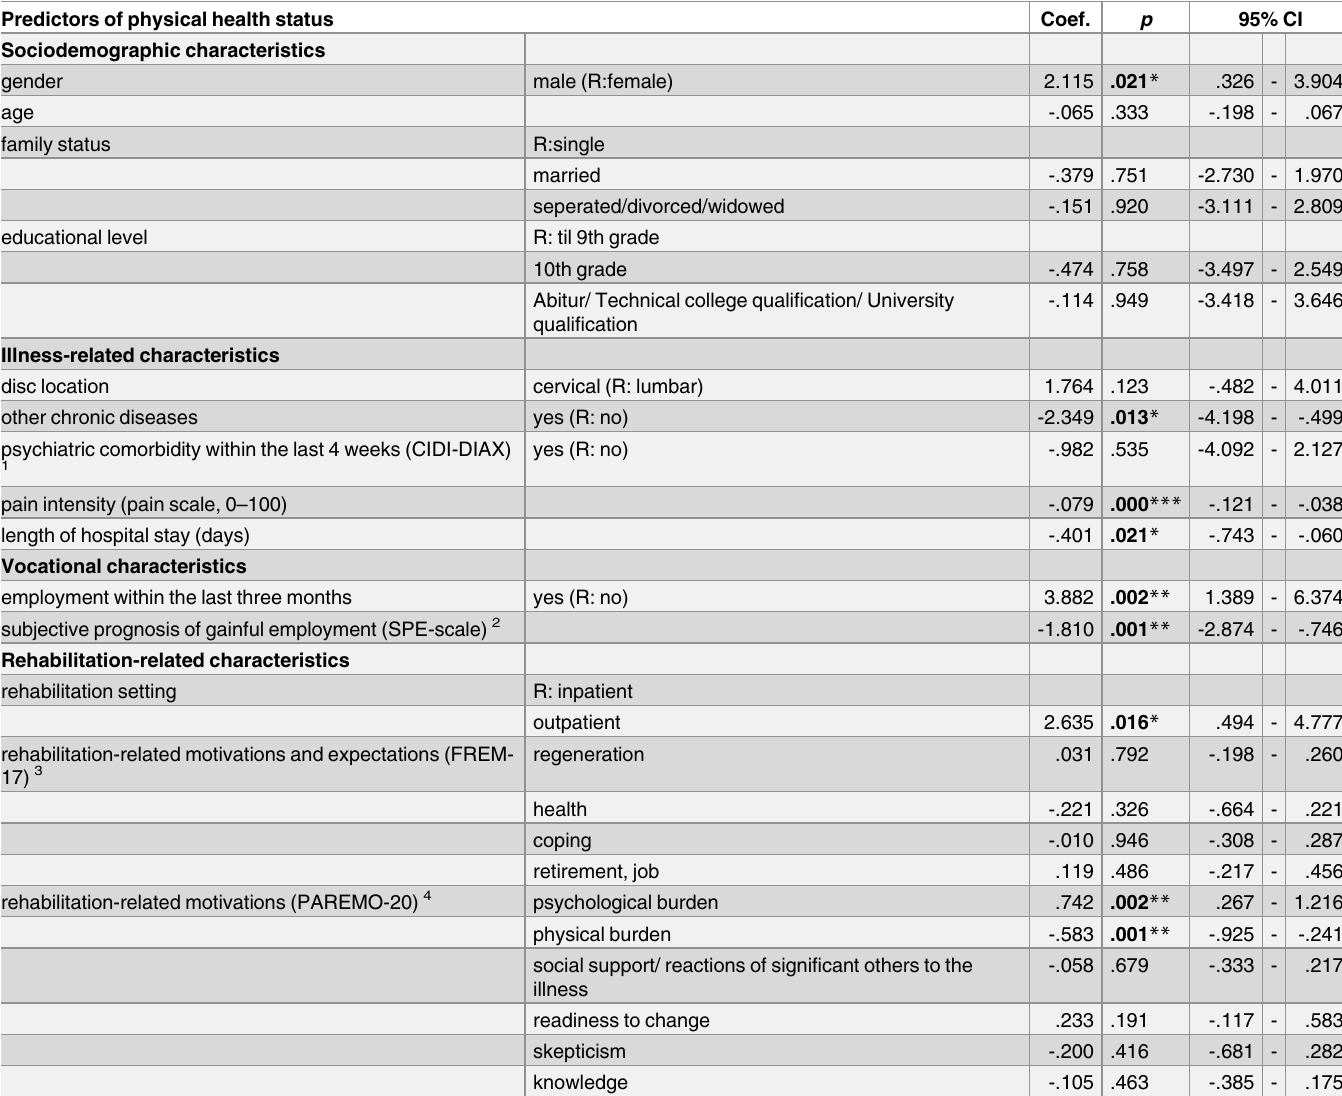
Table 3. Multiple linear regression model of factors associated with physical health status (global score 0–100,SF-36) three months after disc sur- gery (N = 427 a